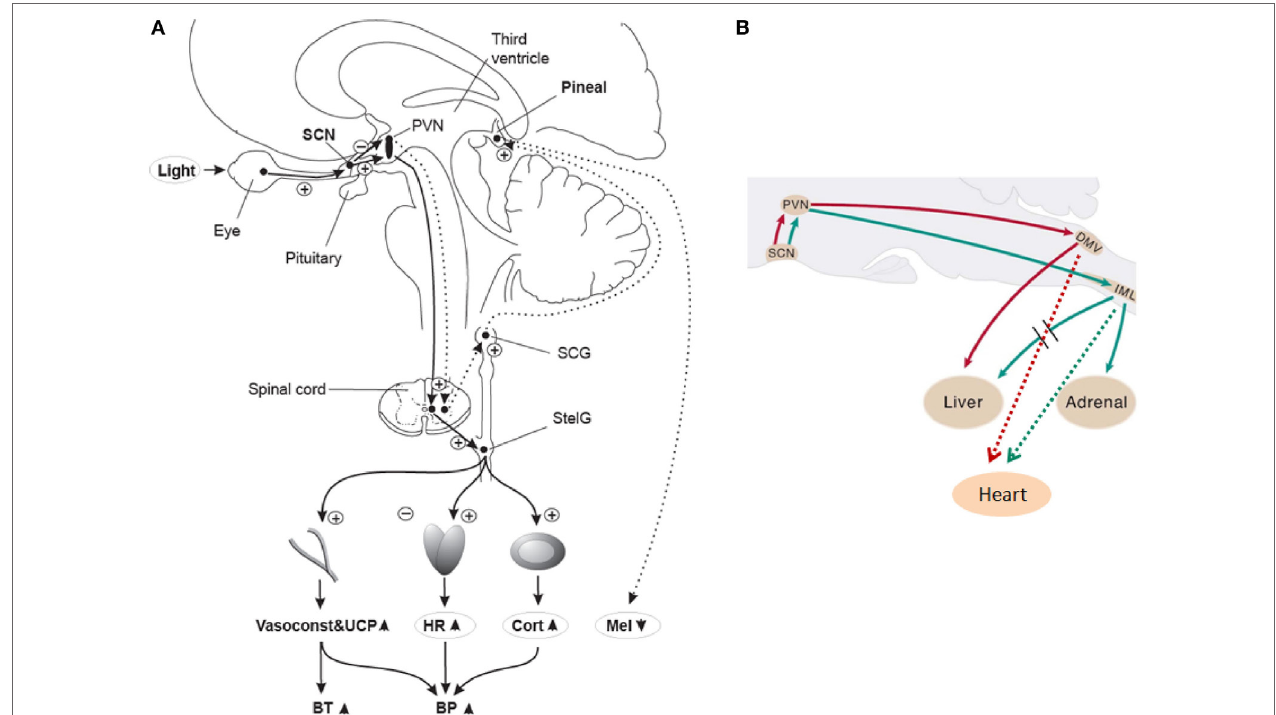
FiGURe 1 | (A) Putative light mechanisms on human cardiovascular system via the suprachiasmatic nuclei (SCN). Human SCN potentially sends different projections to different parts of the PVN to inhibit melatonin in the pineal gland, while stimulating most other SCN-driven rhythms (e.g., HR and cortisol) after light exposure. BP, blood pressure; BT, body temperature; Cort, cortisol; HR, heart rate; Mel, melatonin; PVN, paraventricular hypothalamus nucleus; SCG, superior cervical ganglion; StelG, stellate ganglion; Vasoconstr & UCP, vasoconstriction and uncoupling protein. Continuous lines: active pathways, dotted lines: suppressed pathways. “Plus” signs: stimulation; “minus” signs: inhibition. Reproduced with permission from Scheer et al. (42). (B) Putative sympathetic and parasympathetic outputs from the SCN to peripheral organs via neurons of the rat brainstem. DMV, dorsal motor nucleus of the vagus; IML, intermediolateral spinal cord column. Red lines: parasympathetic output. Green lines: Sympathetic output. Dashed red and green lines correspond to potential output pathways. Modified from Kalsbeek et al. (34).